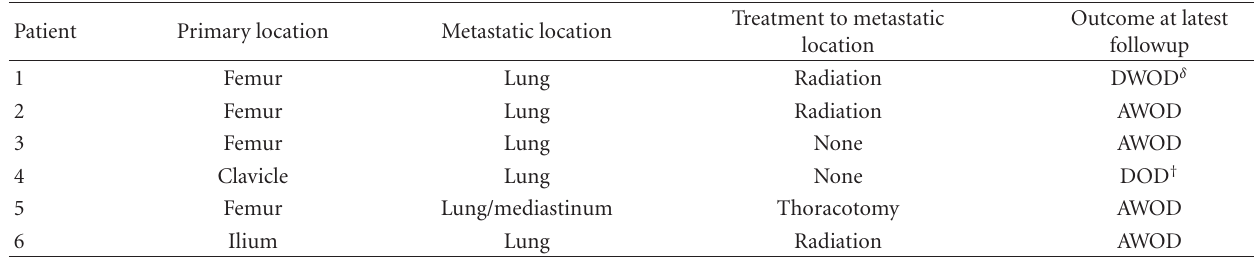
Table 2: Data for patients with single-site metastatic